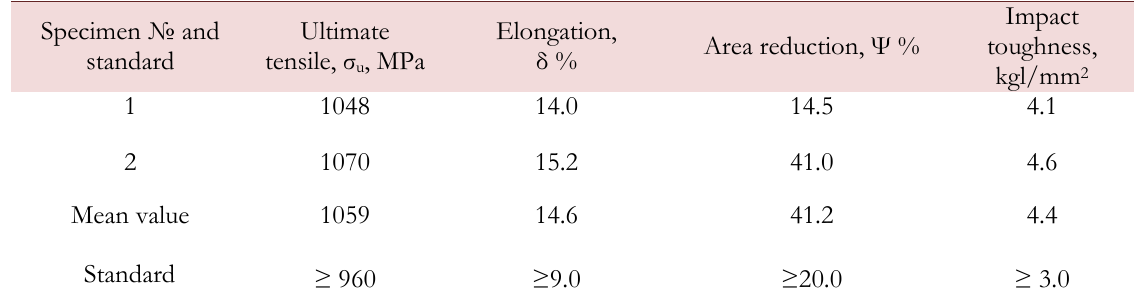
Table 2. Mechanical properties of the rod of titanium alloy VT3-1 at 20°